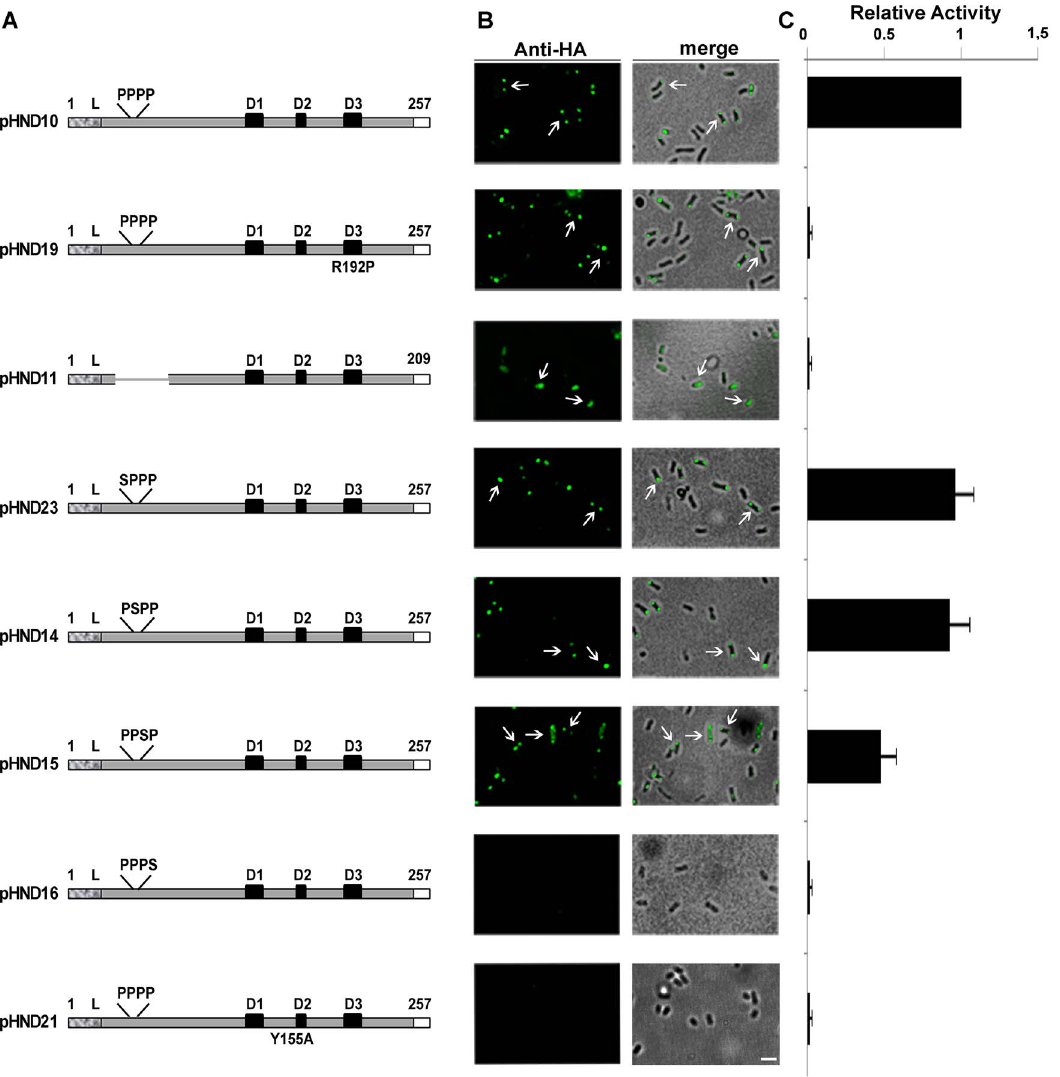
Figure 3. Determination of domains in PhoN2 required for polar localization and catalytic activity. Panel A, in-frame deletion and amino acid substitution mutants of the HA-tagged phoN2 gene. Mutants were generated by PCR, as described in Materials and Methods, using pHND10 (Table S1) DNA as template and the primer pairs reported in Table S2. Amino acid residue 1 represents the first residue of the leader peptide (dotted box), while numbers on the right indicate the last residue of the tagged HA epitope (white box). The positions (not in scale) of the N-terminal polyproline PPPP motif, of the different P to S and of the Y to A amino acid substitutions are indicated. The conserved D1, D2 and D3 domains corresponding to the putative catalytic site of PhoN2 [24,44] and the R192P substitution are indicated. Panel B, fluorescence microscopy and overlay of fluorescence with phase-contrast images of HND115 complemented with each of the PhoN2-HA recombinant plasmids listed in Panel A and grown in the presence of 0.016% of L-arabinose. Bacteria were labeled with anti-HA monoclonal antibody (green). Arrows indicate polar foci of PhoN2-HA. Panel C, units of ATP-hydrolyzing activity; one unit corresponds to 1 m mol of P i min 2 1 mg 2 1 of protein; means 6 standard deviations (error bars) of experiments that were performed more than three times. Images are representative. Bar =2 m m.